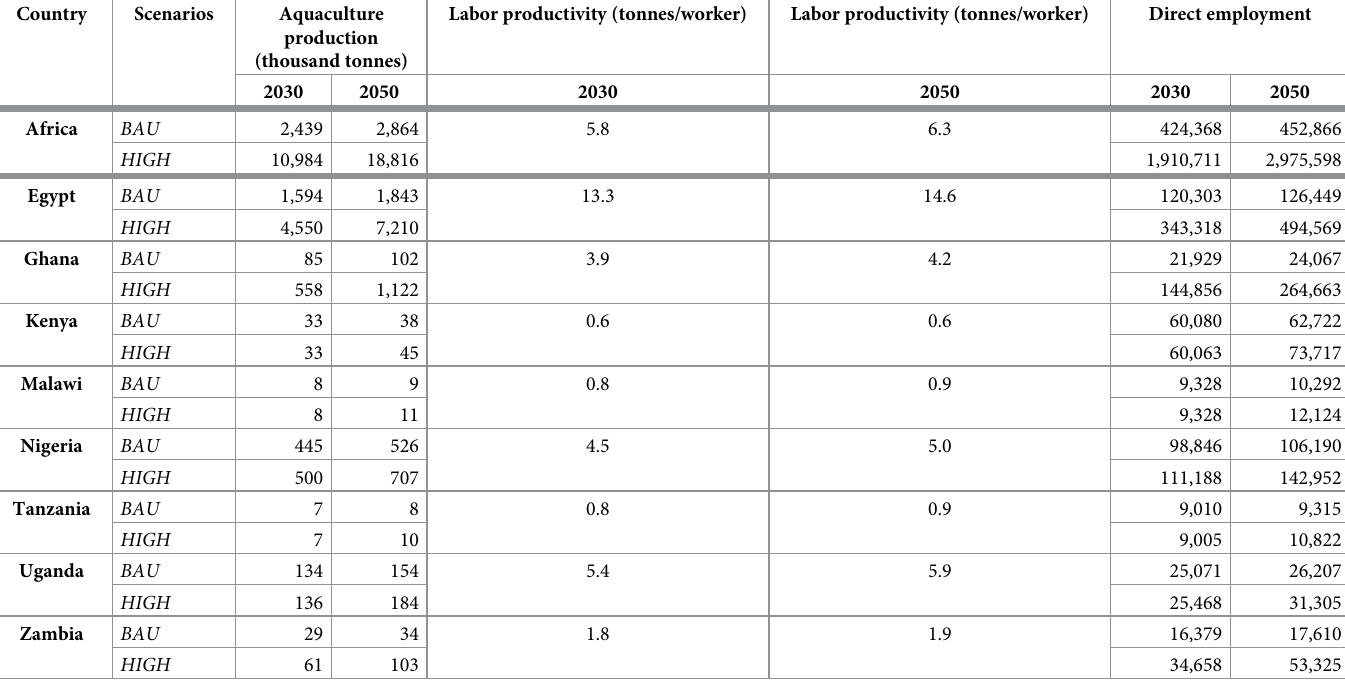
Table 5. Estimated direct employment of Africa’s aquaculture sector for BAU and HIGH scenarios in 2030 and 2050. Country